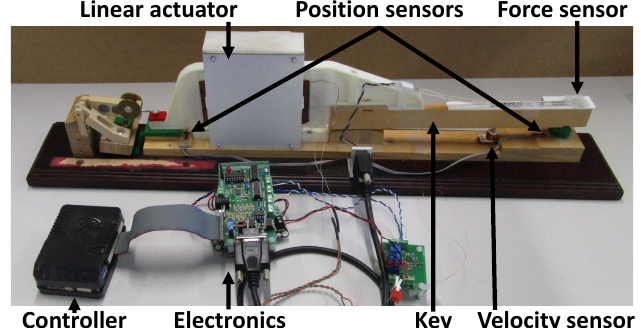
Figure 11. Mechatronic design of one key haptic feedback device, enhanced from the work in [52].